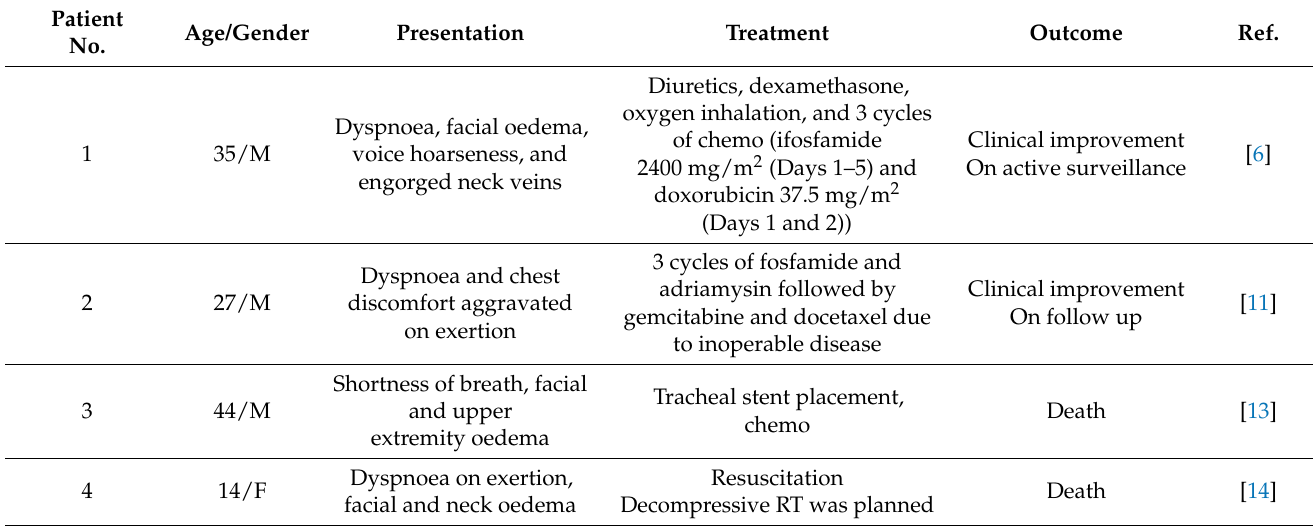
Table 1. Total reported cases of patients with mediastinal monophasic spindle-cell synovial sarcoma who developed SVC